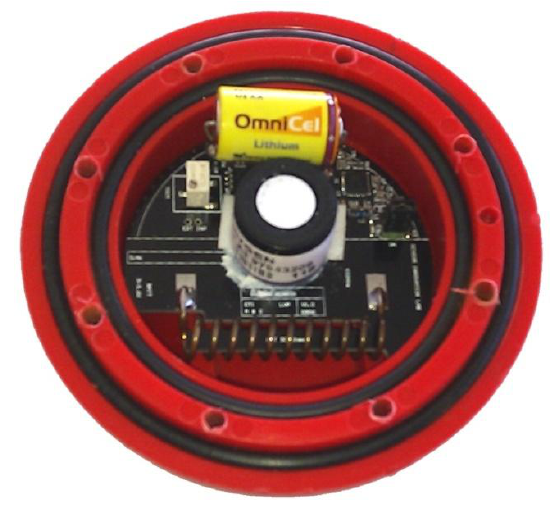
Figure 2. The sensor unit for temperature and oxygen consecration measurements within the protective